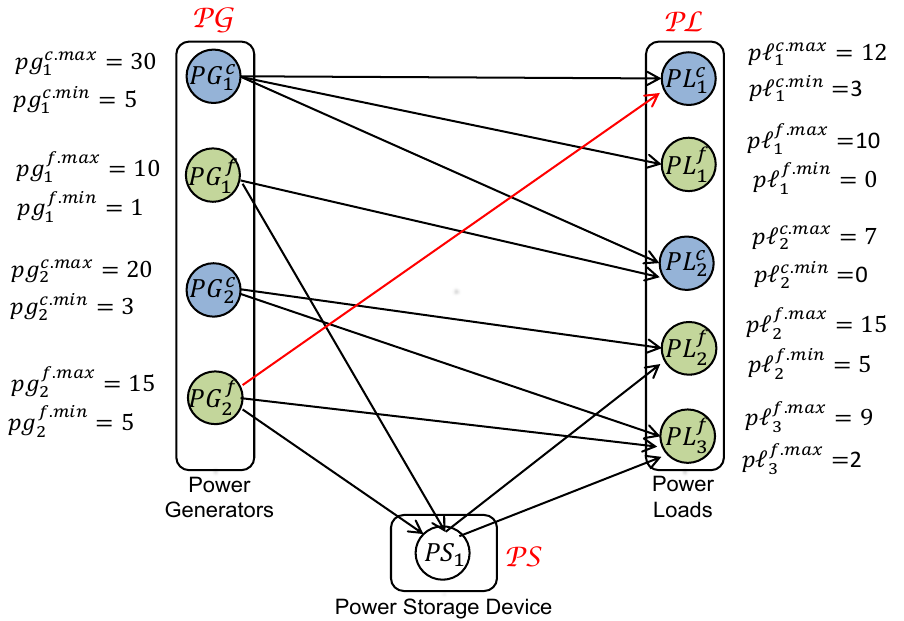
Figure 15. Example demonstration when PG f